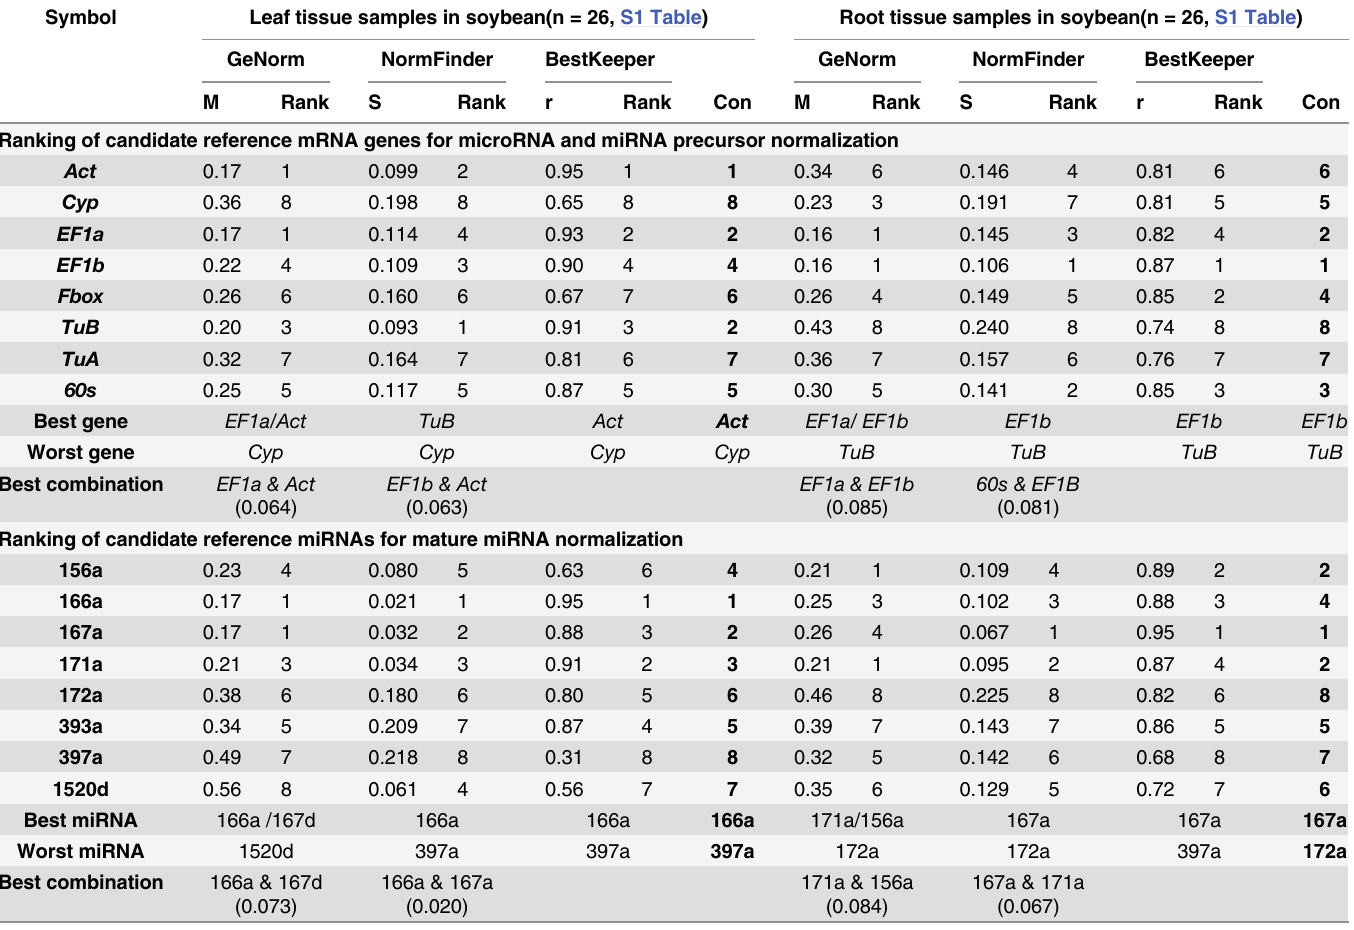
Table 2. Ranking of candidate reference mRNAs and candidate reference miRNAs using the geNorm, NormFinder, and BestKeeper algorithms. Symbol Leaf tissue samples in soybean(n = 26, S1 Table) Root tissue samples in soybean(n = 26, S1 Table)